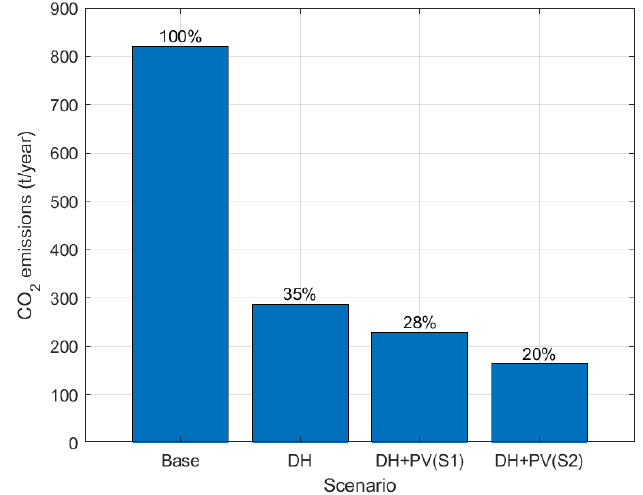
Figure 8. Effect of renewable district heating and PV systems on equivalent CO 2 emissions.